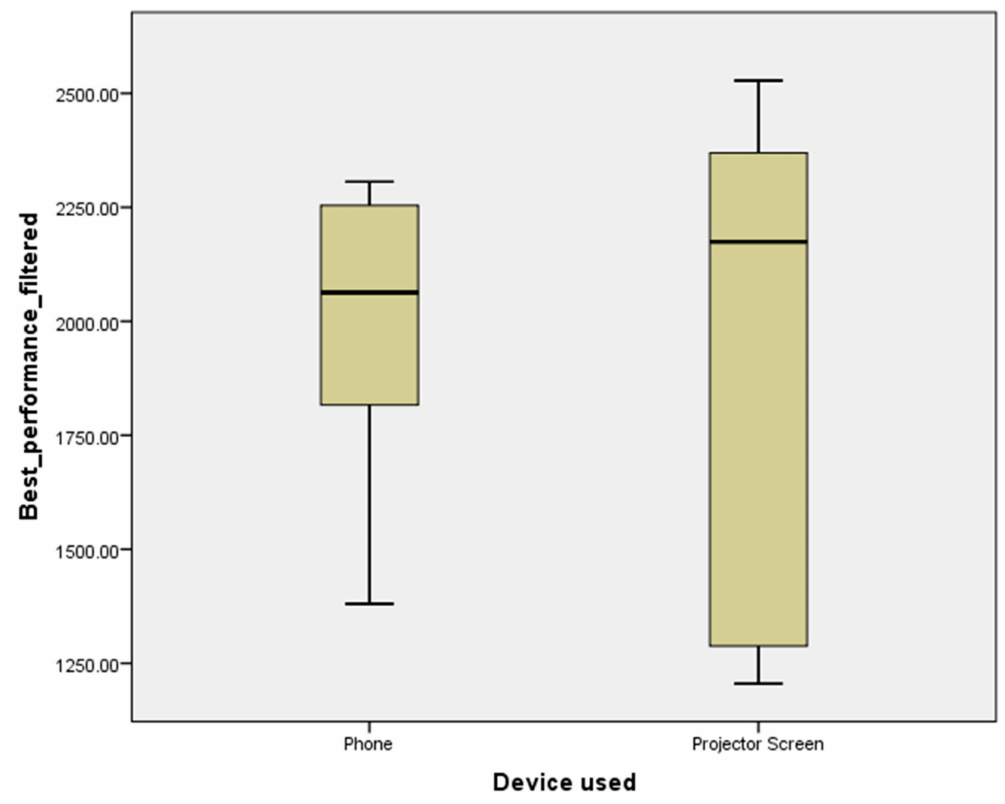
Figure 7. Boxplots for best performance scores for filtered data.